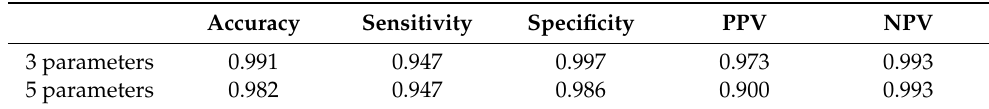
Table 3. Statistics of the accuracy, sensitivity, specificity, PPV, and NPV of logistic regression with three and five